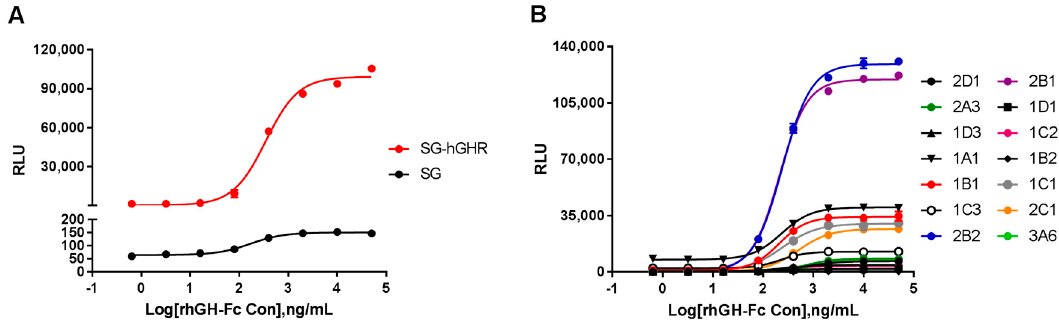
Figure 1. The responsiveness of transfected HEK293 cells to Fc-fusion recombinant human growth hormone (rhGH-Fc). ( A ) The responsiveness of stably transfected HEK293 cell pools to rhGH-Fc. The signal-to-noise ratio (SNR) of HEK293 cells expressing SG-hGHR was significantly higher than that of those having the SG response element. ( B ) The establishment of a responsive HEK293-Luc cell line to rhGH-Fc. Clonal cell line 1B1 was superior to other thirteen clonal cell lines in term of its 50% effective concentration (EC 50 ) and SNR. SG-hGHR, SIE and GAS response elements (SG) and human growth hormone receptor (hGHR).